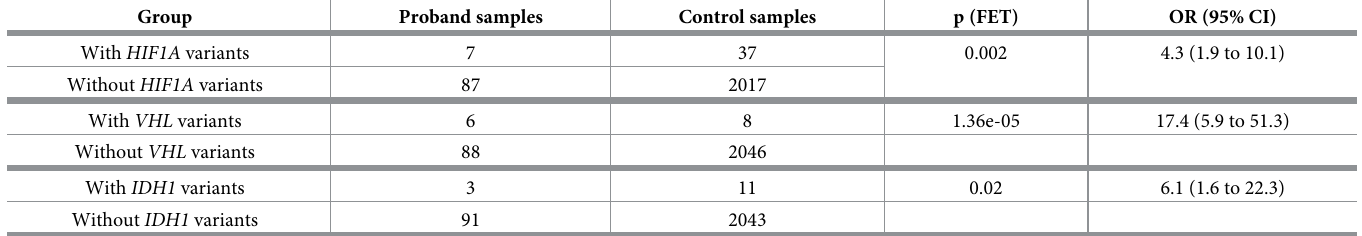
Table 2. Burden analysis results showing statistically significant difference when comparing the number of rare functional variants in the proband group to the control group for HIF1A , VHL , and IDH1 .